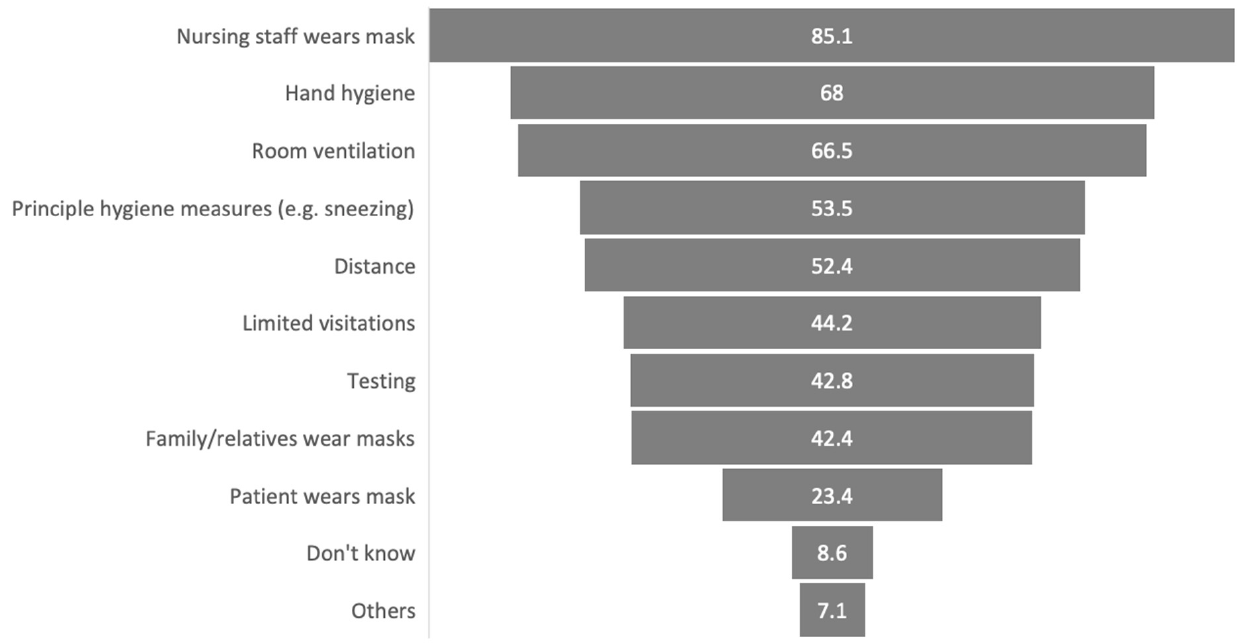
Figure 3. Sanitary measures during care sessions in the p-LTC group in %. Sanitary measures used during professional care sessions are listed as percentage of people with Parkinson’s disease with professional care ( n = 269). Multiple answers were allowed here.